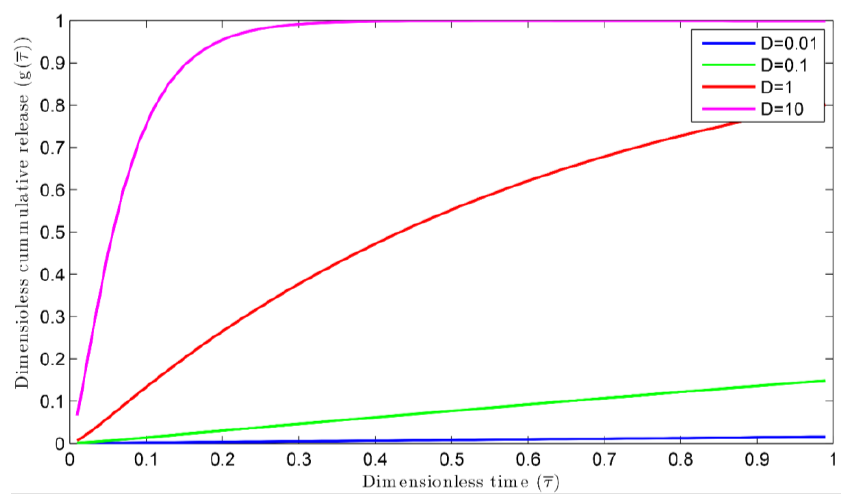
Figure 2. Dimensionless cumulative release versus dimensionless time for different diffusion coefficients.